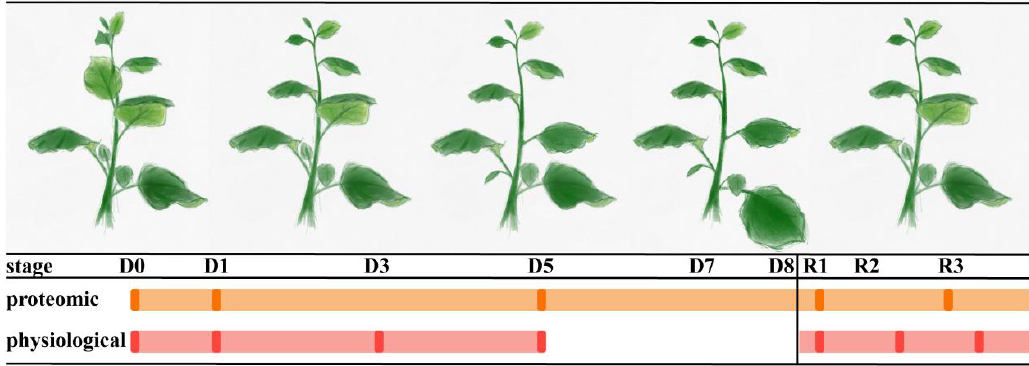
Figure 1. An illustration of Nicotiana benthamiana treatment stages and sampling points. D0: no-drought stress, D1–D8: 1 d–8 d of drought treatment, R1–R3: 8 h–48 h of re-watering. Bars were represented as the duration of treatments. Samples obtained at the shown points were used for proteomic and physiological analysis, respectively.